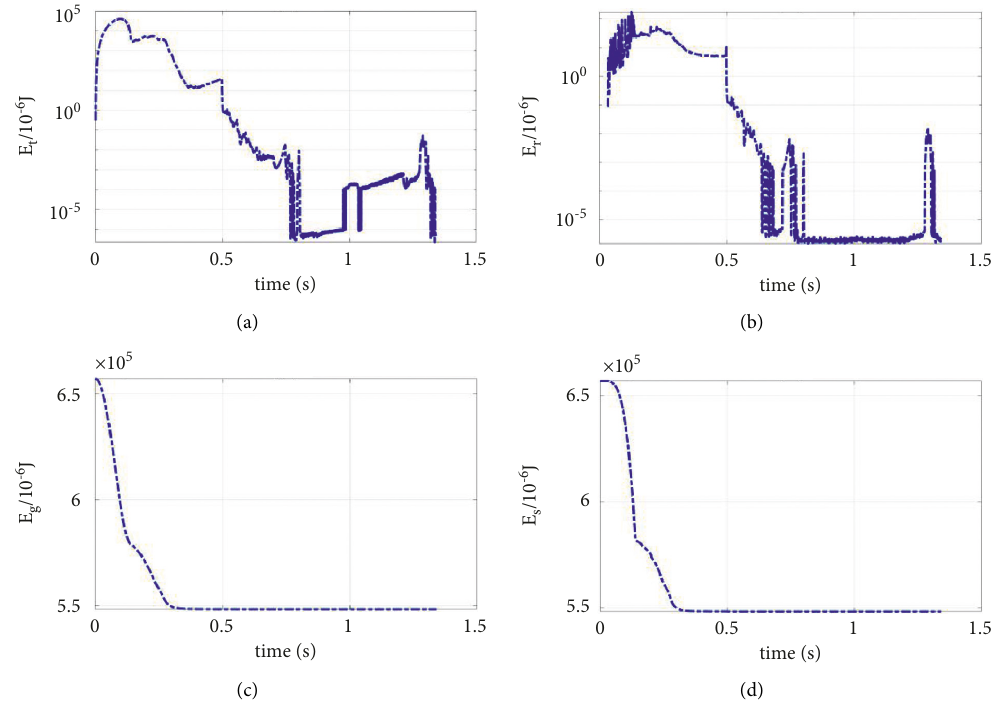
Figure 12: Energies change with time. (a) Translational energy, (b) rotational energy, (c) gravity potential energy, and (d) total energy.